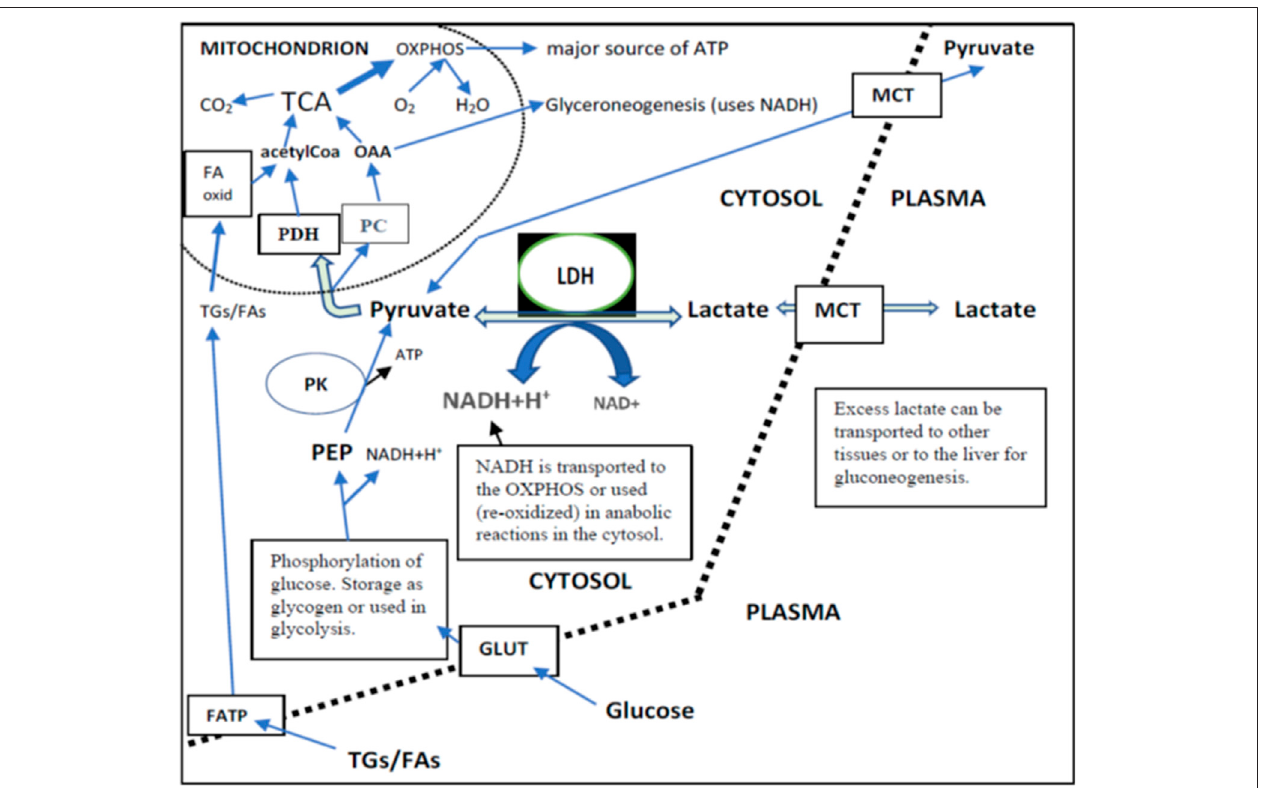
FIGURE 3 | Lactate, pyruvate, glucose, and TGs/FAs in fl ow from plasma and their intracellular metabolism in a cell that can use both FAs and glucose as the main sourceofenergy.Independentlyoftheir fi naluseinmetabolism(liverorperipheraltissues),theintracellulardirectionoflactateviapyruvateistowardsmitochondria.Thisis because the cytosolic PK reaction is irreversible. TCA produces most of the NADH for OXPHOS. Glycolysis produces 2 NADH per one glucose. There existed a very strong correlation betweenthechangesofplasmapyruvate andlactateindependentlyofplaceboorDGAtreatment( > 0.90).Thiscorrelation strongly indicates that MCTs are able to balance plasma membrane concentration differences ef fi